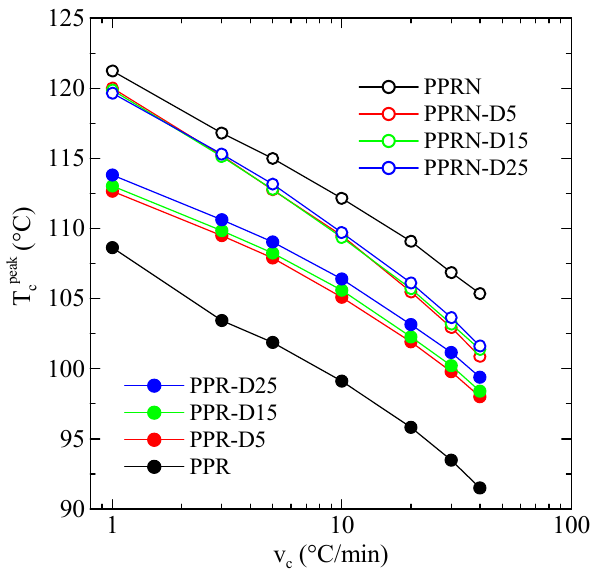
Figure 6. Variations in the peak crystallization temperature with the cooling rate for the different samples.